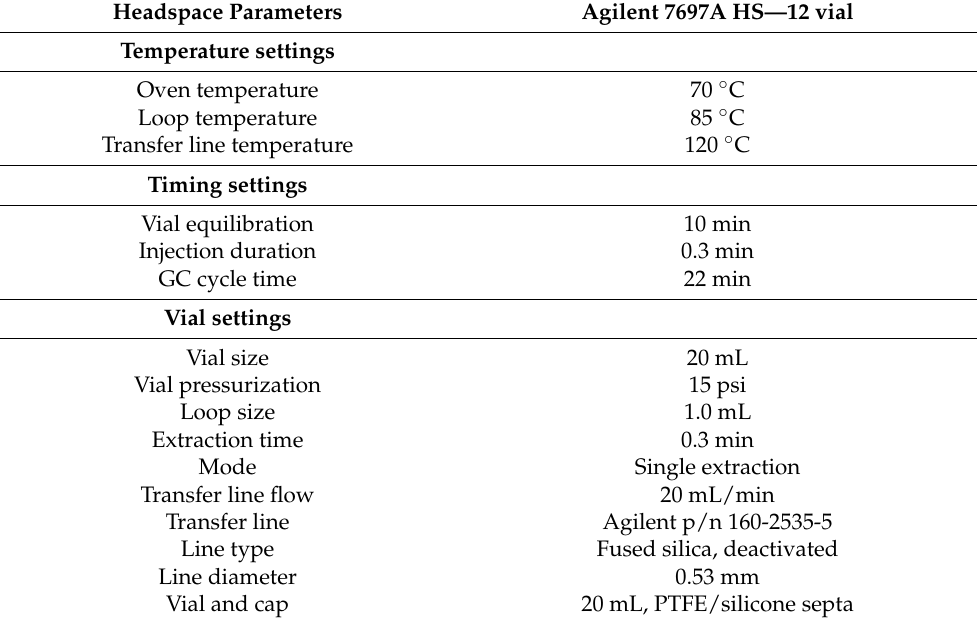
Table 2. GC–MS HS method